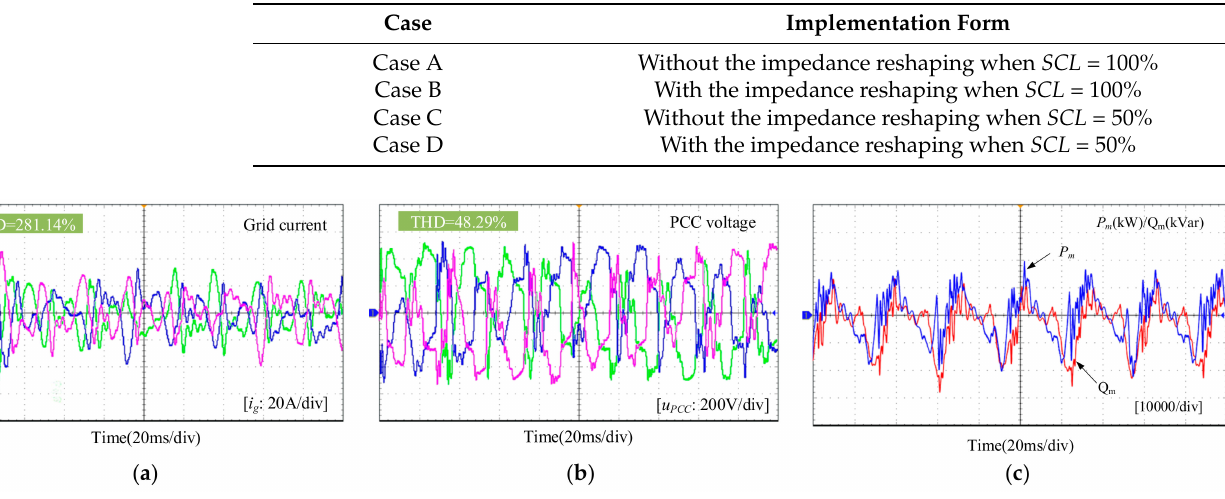
Figure 15. Experiment results with no impedance reshaping control strategy when SCL = 100%. ( a ) Grid current, ( b ) PCC voltage, ( c ) active and reactive power.